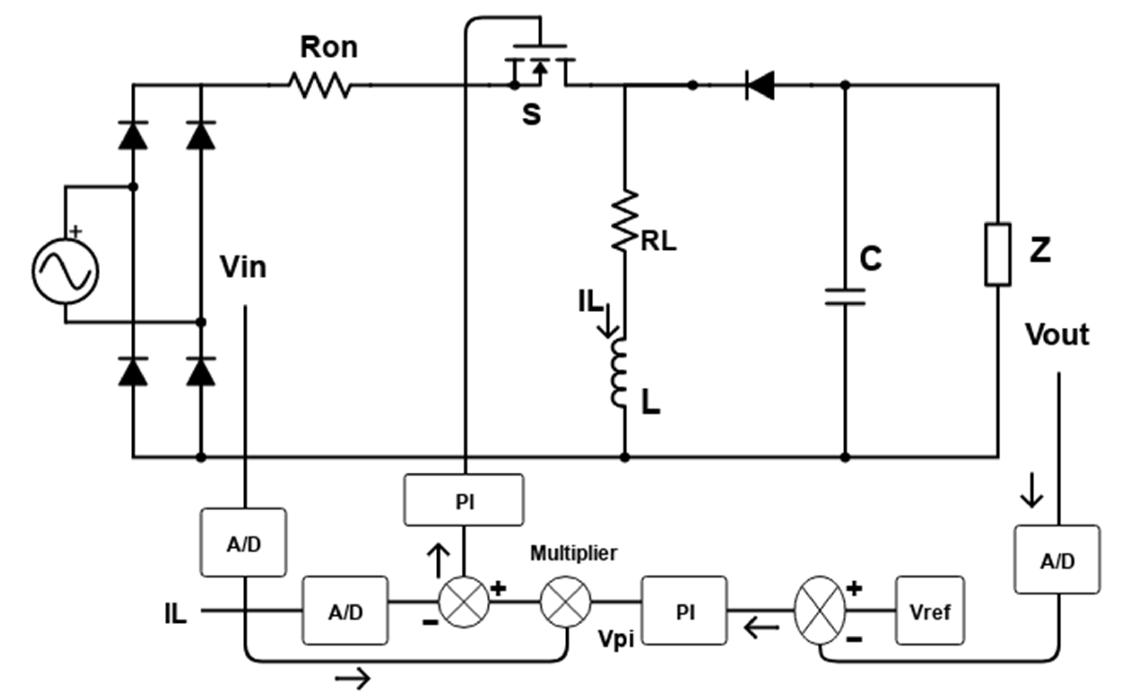
Figure 1. Buck ‐ boost converter PFC with AICMC control technique. Figure 1. Buck-boost converter PFC with AICMC control